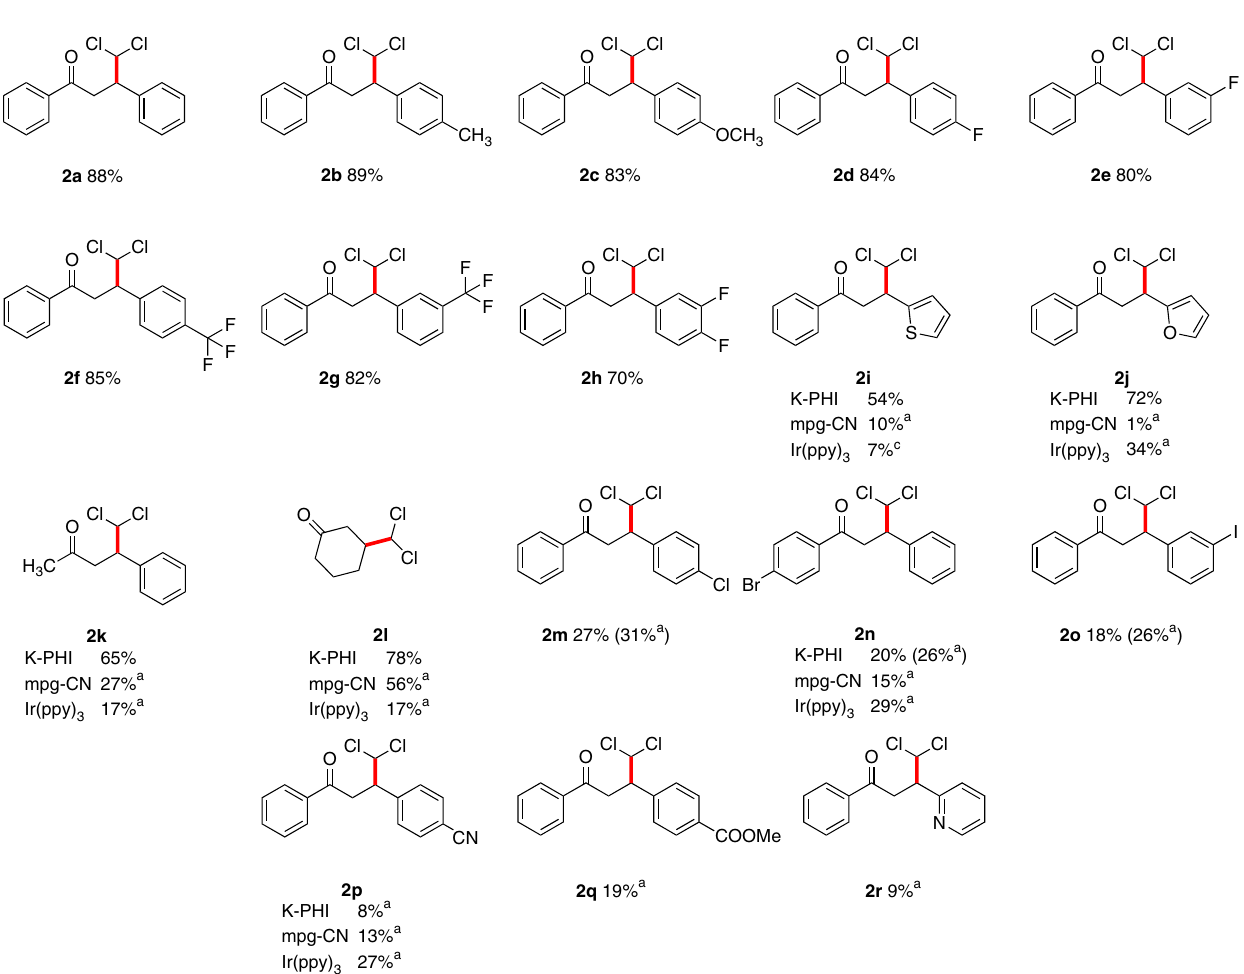
Fig. 2 Scope of enone substrates. Reaction conditions: enone 1 (1 eq., 0.05 mmol); TEOA (10 eq., 0.5 mmol, 67 µ L); CHCl 3 (2 mL); Argon atmosphere; under light irradiation ( λ = 461 nm, 51 ± 0.03 mW cm − 2 , blue LED), isolated yields. Superscript “ a ” indicates the yields determined by 1 H NMR using 1,2,3- trimethoxybenzene as internal